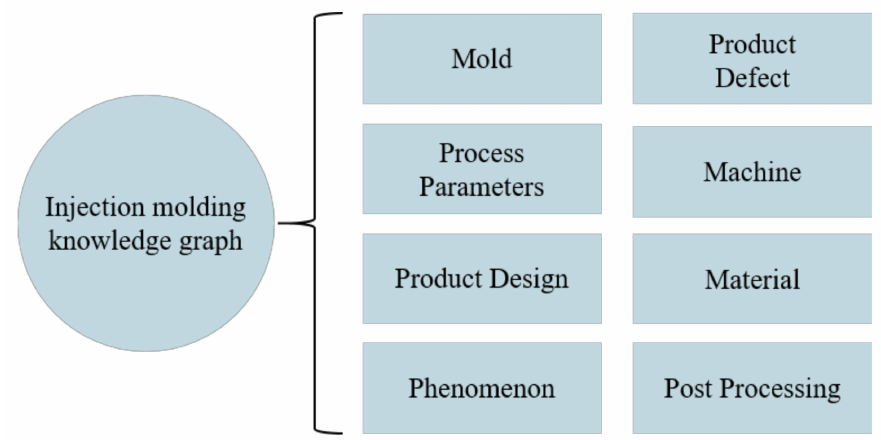
Figure 4. Entity